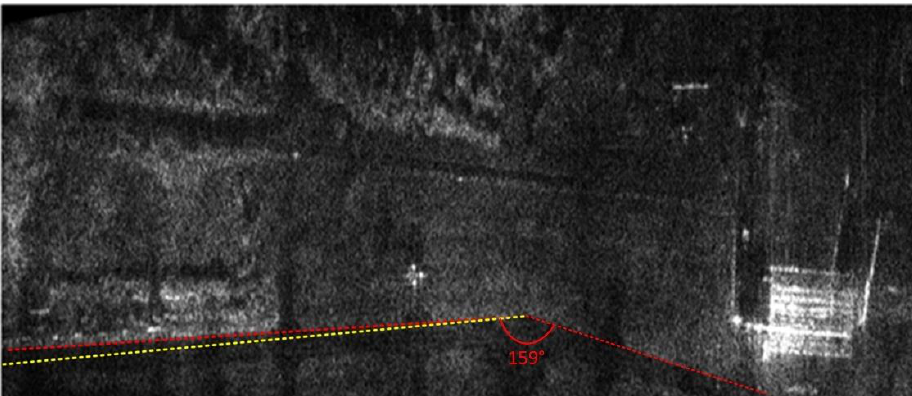
Figure 13. Radar terrain image obtained with the use of INS/GPS data; yellow line—the north edge of the taxiway determined using INS-based image, red line—the north edge of the taxiway determined using an INS/GPS-based image.